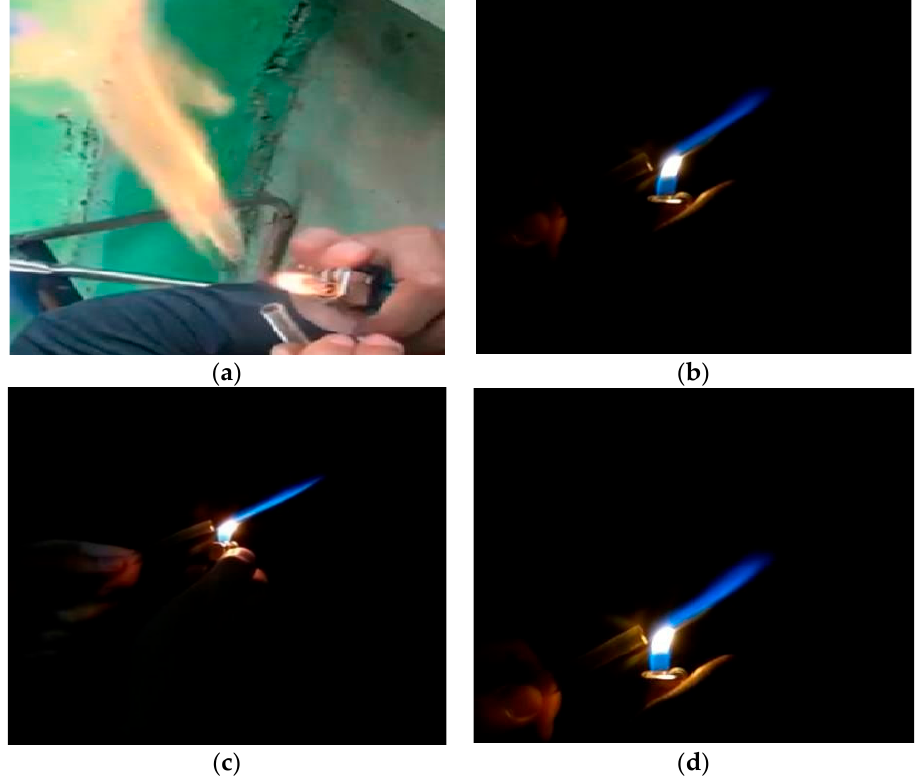
Figure 8. Flame test ( a ) without using a membrane, ( b ) 0.5 M HCl, ( c ) 1 M HCl, and ( d ) 1.5 M HCl PEFB adsorber membrane.